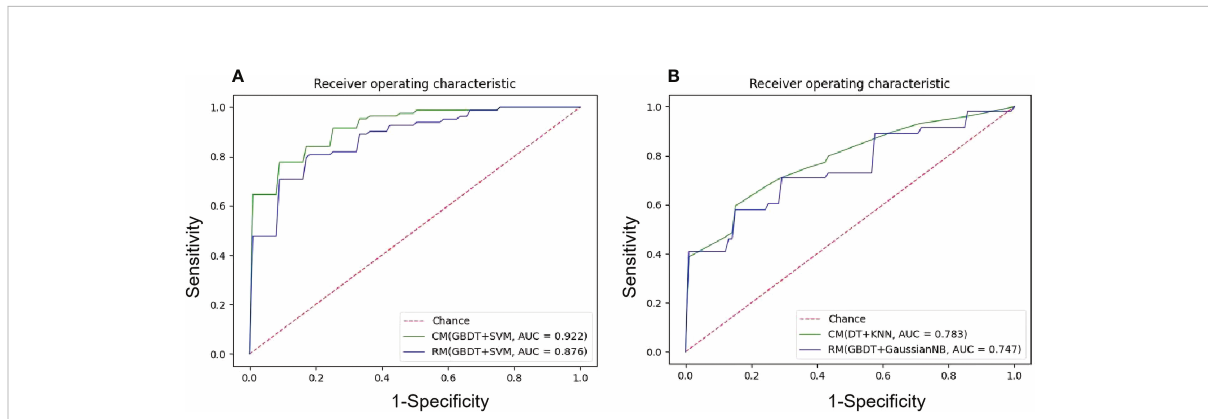
FIGURE 3 The ROC curves of the best ML models. (A) NECT-based RM and CM with(GBDT+SVM) in the testing sets in group1, mean AUC of 0.876 and 0.922 were presented; (B) NECT-based RM with (GBDT+GaussianNB) and CM with (DT+KNN) in the testing tests in group 2, mean AUC of 0.747 and 0.783 were presented.